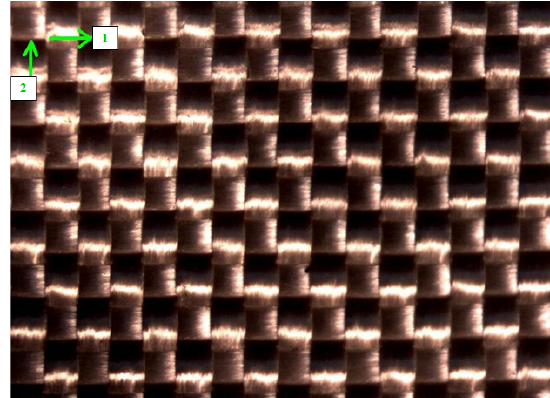
Figure 3: Stereo microscopy of 200 gsm woven